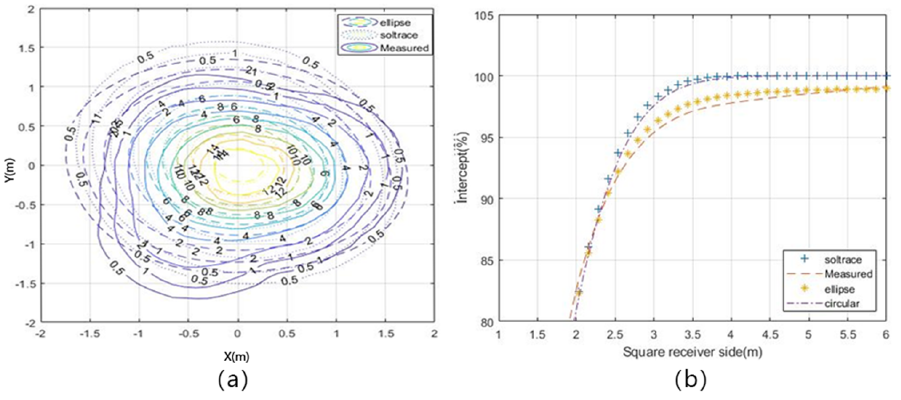
Figure 9. ( a ) Contours of the measured and computed flux distribution (kW/m 2 ): Heliostat #3, ( b ) measured and computed intercepts vs. the side length of a square receiver: Heliostat #3